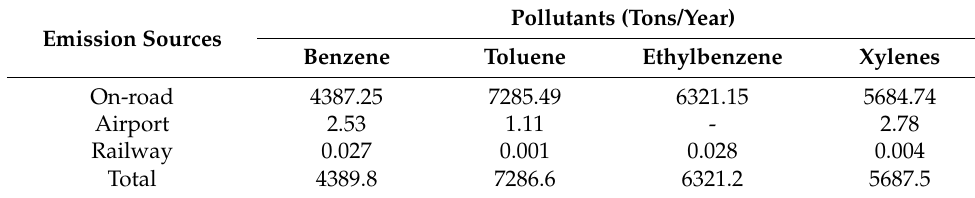
Table 2. Emission From Traffic.